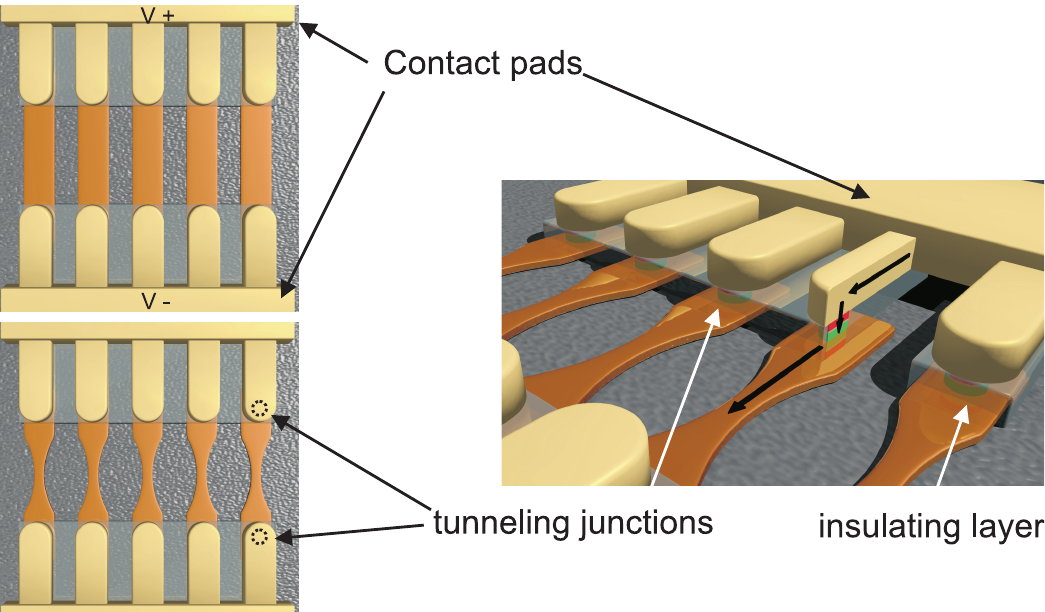
Figure 1. Schematic drawing of the microstructure for fast lifetime measurements. The images on the left show a top view of the two alternative designs with wide (W) and narrow (N) fuse layer. The dashed circles marked the position of the buried junctions. The right image show a side view where a section has been removed to show the junction area. The black arrows indicate the current flow. The drawings are not to